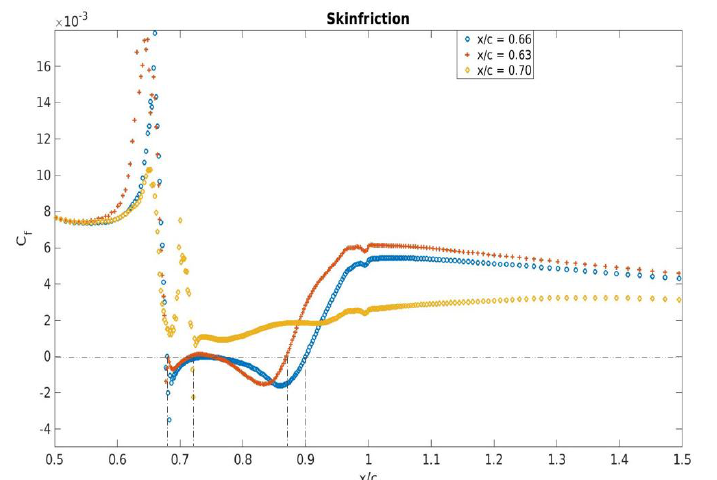
Figure 21. Coefficient of skin friction comparisons for different plasma actuator locations.